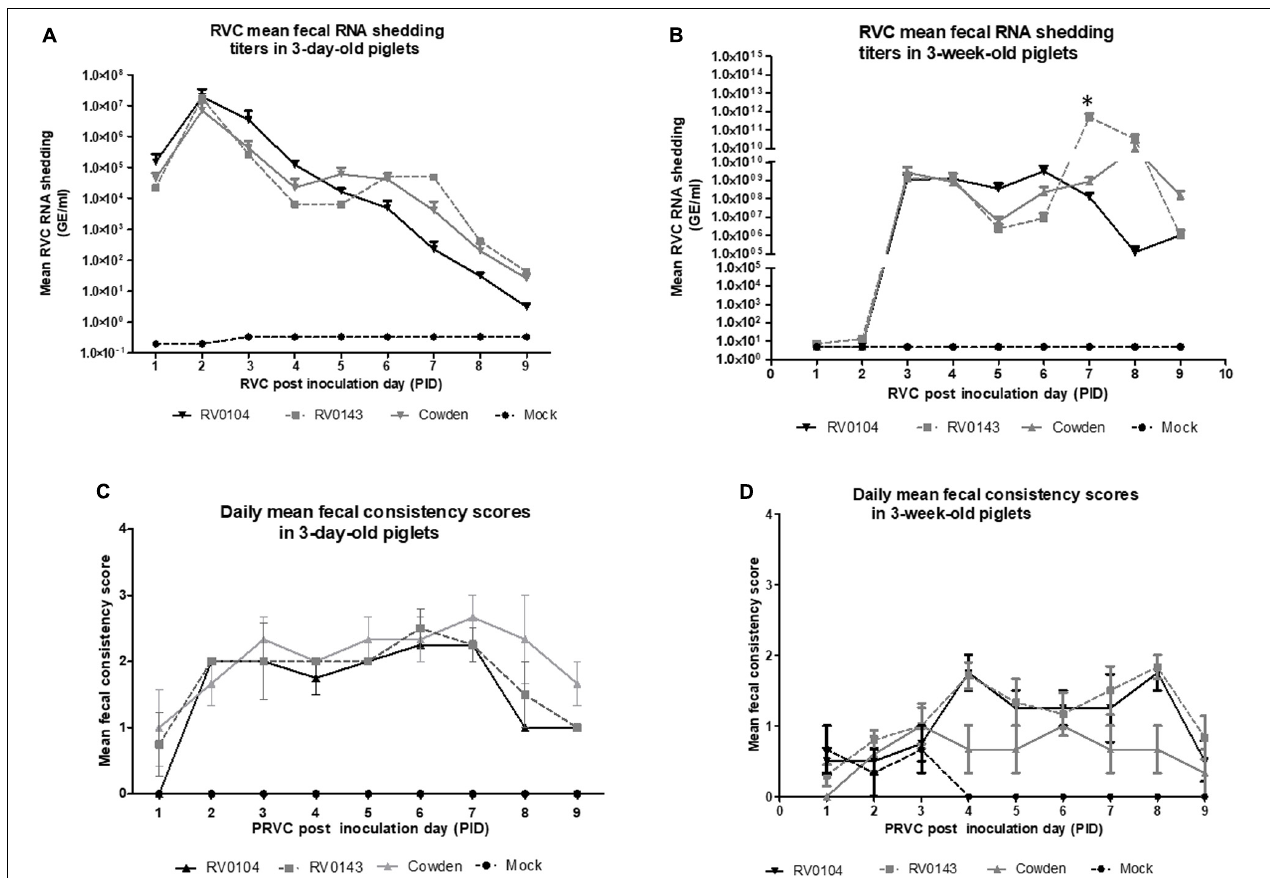
FIGURE 1 | Mean ( ± SEM) daily fecal diarrhea score and mean ( ± SEM) PRVC diarrhea fecal shedding of porcine RVC infected Gn piglets. 3-day-old and 3-week old Gn piglets were infected with 10 5 RNA copy/ml of porcine PRVC Cowden, RV0104, and RV0143 and mock and piglets were examined daily for (A,B) . fecal RNA shedding (RNA copy/ml) and (C,D) . diarrhea and their fecal score noted as follows: 0 – normal = solid; 1- pasty; 2- semi-liquid; and 3, liquid diarrhea from PID 1-PID 9 and mean ( ± SEM) daily fecal diarrhea was calculated from the